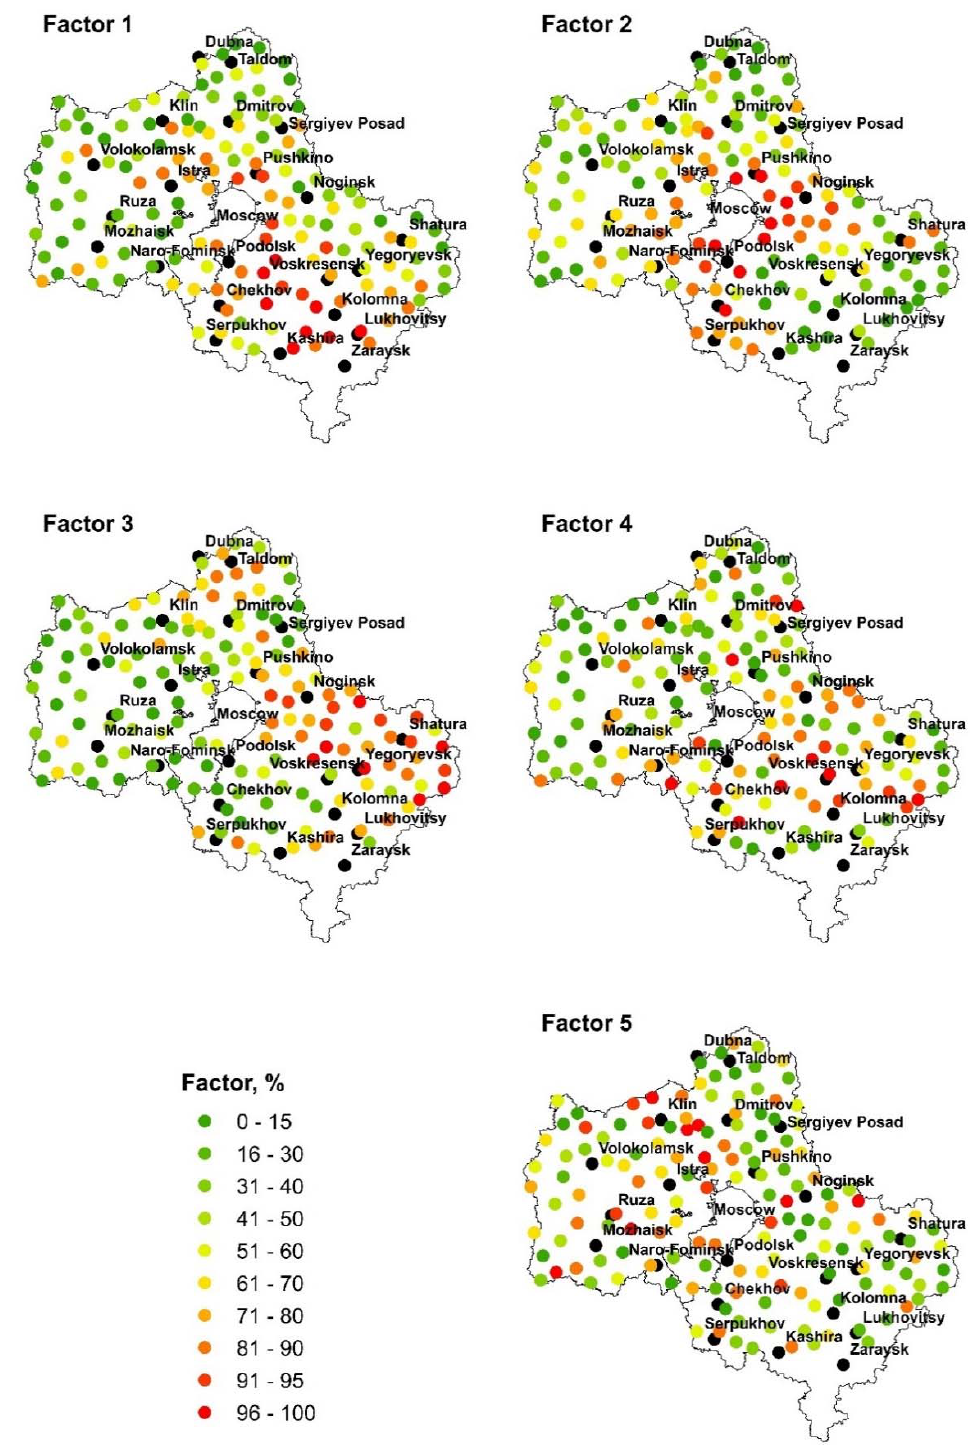
Figure 2. Spatial distribution of Factors 1–5 scores.